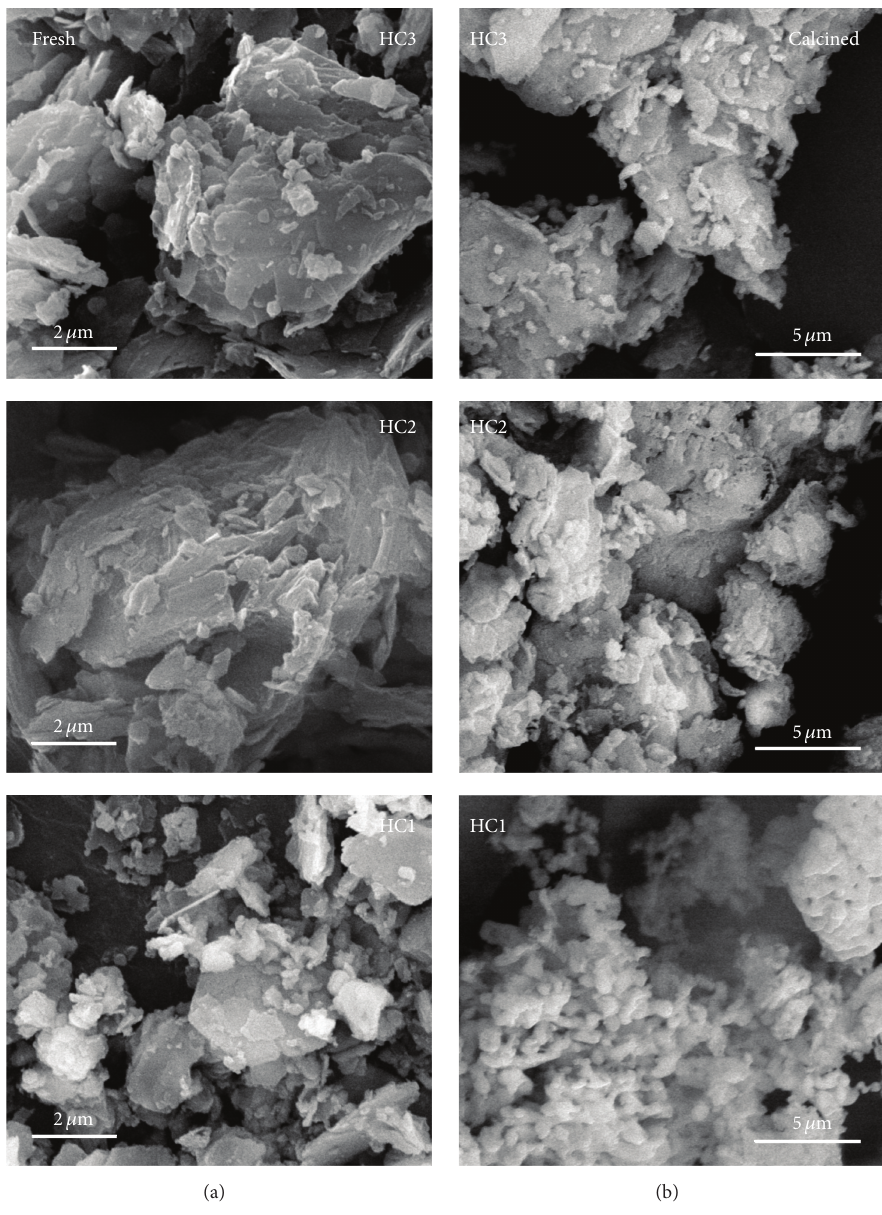
Figure 5: SEM images of the fresh and calcined